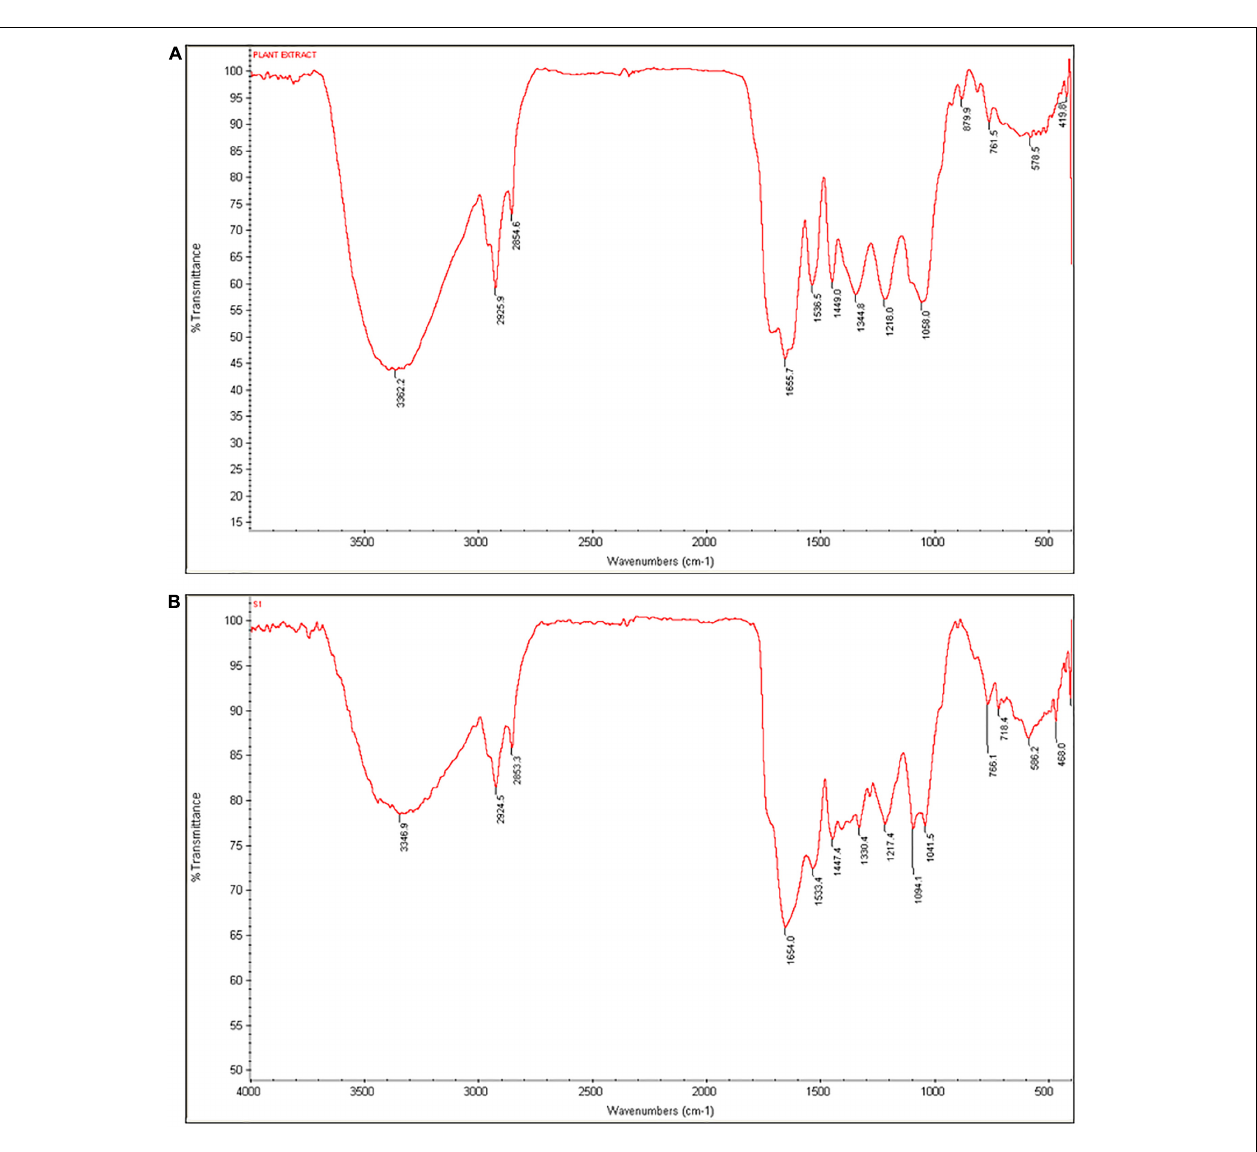
FIGURE 3 | FTIR spectra of (A) C. papaya fruit extract and (B)